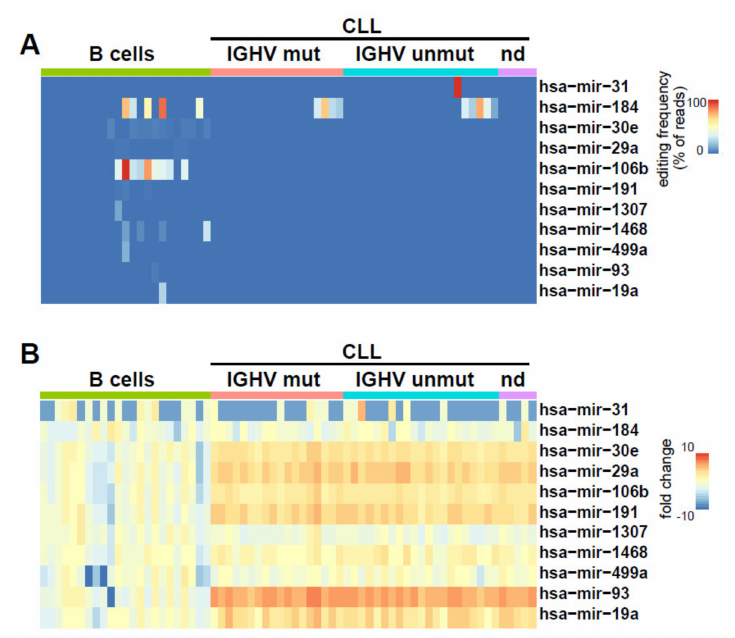
Figure 2. C to U editing in miRNAs from CLL and normal B cells. ( A ) Editing frequencies are indicated as a heat map in CLL ( n = 44) and normal B cells ( n = 23). ( B ) The heat map shows the fold change in miRNA expression in normal B cells versus CLL cells, normalized to mean expression in normal B cells.